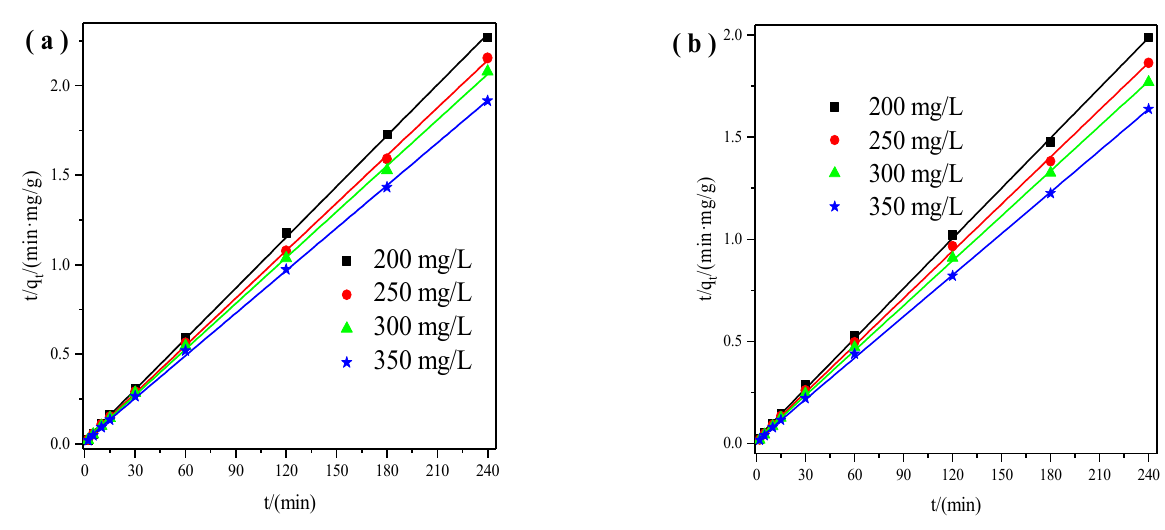
Figure 3. Pseudo − second order model of X zeolite for Cu 2+ ( a ) and Zn 2+ ( b ). Tables 1 and 2 summarized the calculated parameters of the pseudo-first and pseudo- second-order model. The correlation coefficients (R 2 ) of the pseudo-second-order model ranged from 0.9995 to 0.9997, and the pseudo-second-order model ranged from 0.7519 to 0.0.9867. The correlation coefficients suggested that the adsorption kinetics can best fit the pseudo-second-order model, which indicates that chemical sorption played an important effect during its adsorption process. It may be owing to the exchange of electrons between X zeolite and Cu 2+ or Zn 2+ metal ions [32]. Meanwhile, it found that the values of initial sorption rate (h) increased at a higher initial concentration, which indicated that a higher driving force produced by the concentration gradient can promote the adsorption process [22]. Furthermore, the maximum adsorption capacities for Cu 2+ and Zn 2+ could reach 126 and 148 mg/g,